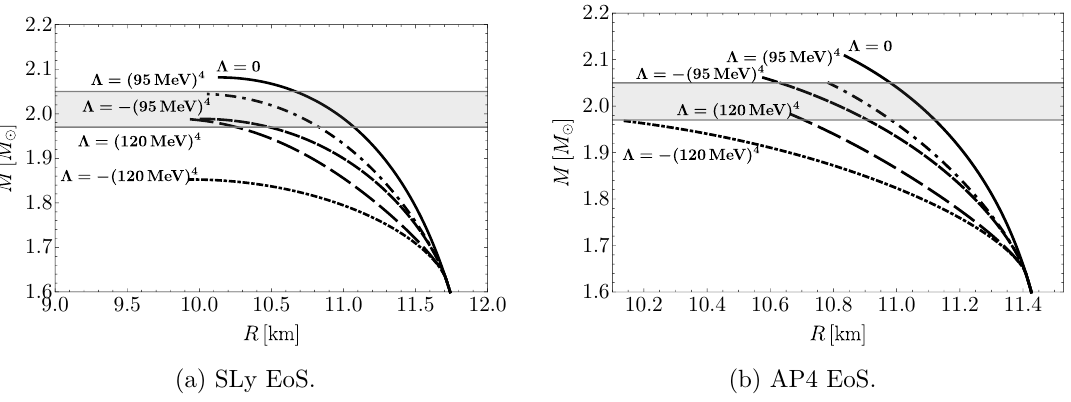
Figure 2. M ( R ) curves for the SLy and AP4 equations of state for various (cid:3) values on the seventh layer. For all the curves, the proportionality constant (cid:11) in the jump equation (2.14) is chosen to be (cid:11) = 3. The gray region shows the allowed mass range of the heaviest neutron star, with mass (2 : 01 (cid:6) 0 : 04) M (cid:12)